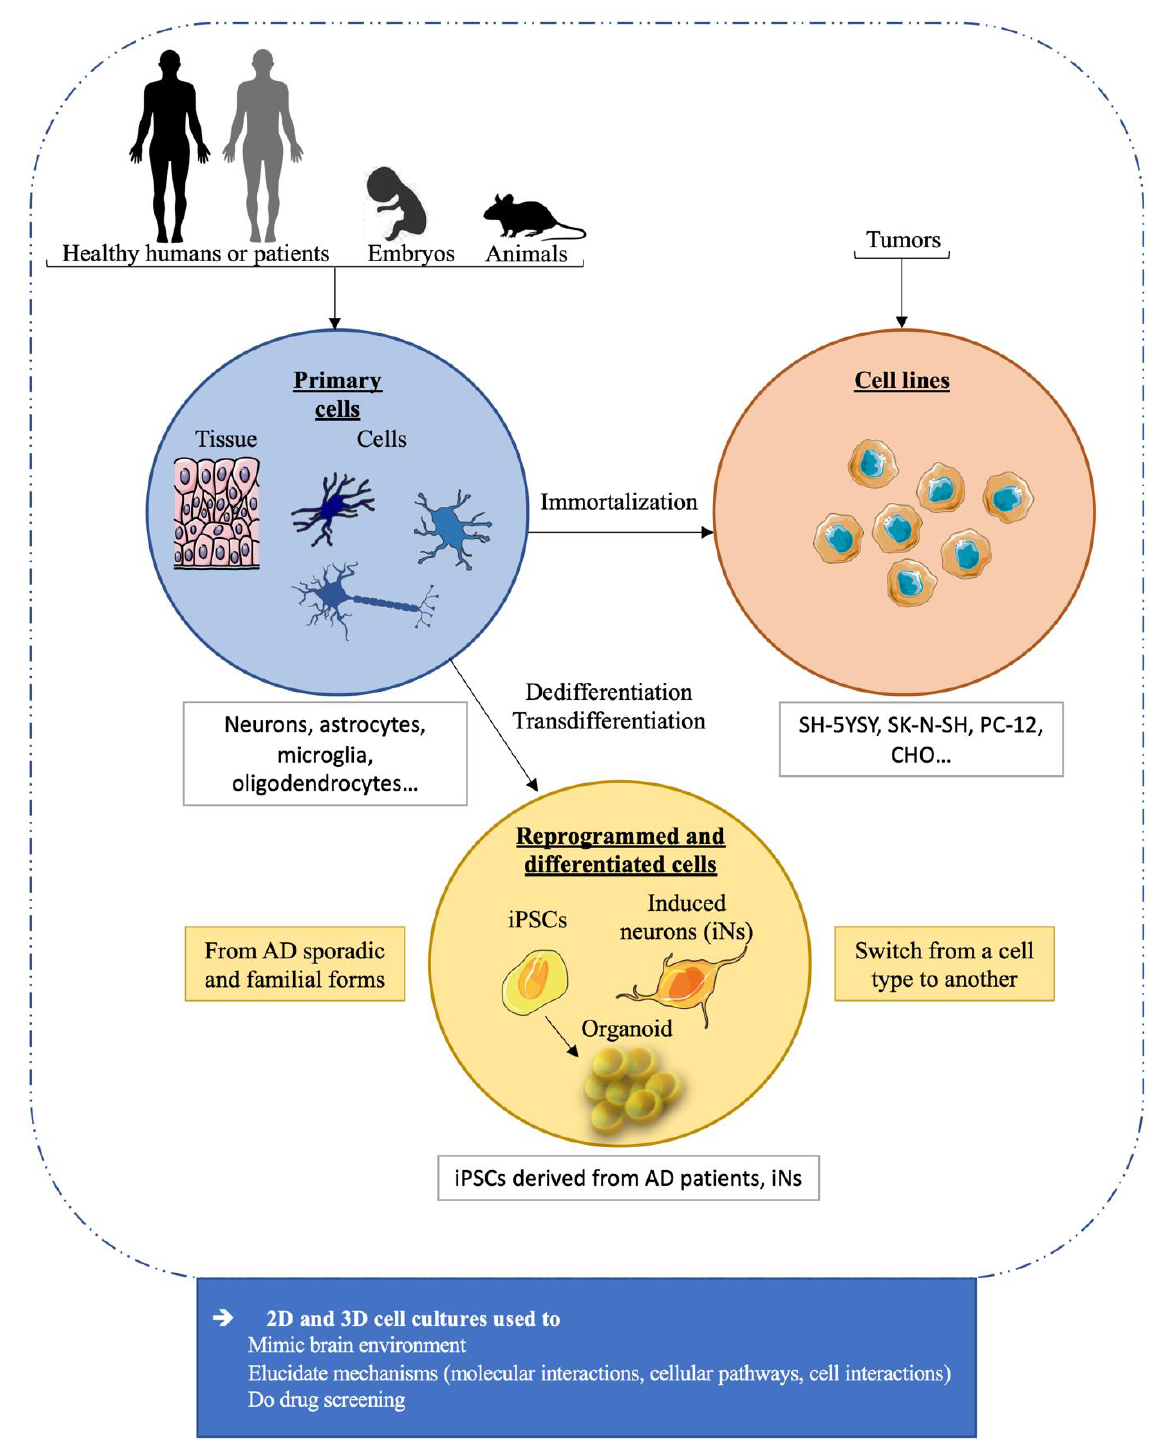
Figure 3. In cellulo models used in AD studies. The cell schemes are adapted from the bank image of Servier medical art smart.servier.com and are licensed under CC BY 3.0. Abbreviations. iPSCs: induced pluripotent stem cells; iNs: induced neurons.